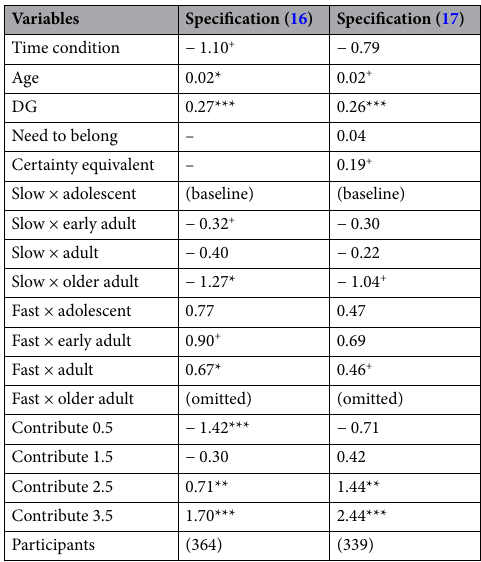
Table 10. Ordered probit estimates of specifications (16) and (17). + p < 0.15 (marginally significant), *p < 0.05, **p < 0.01, ***p <